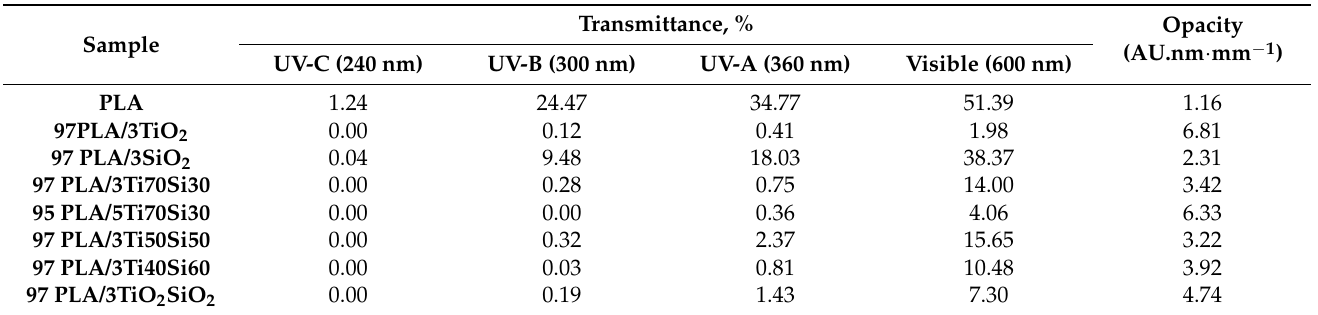
Table 4. Transmittance (%) and opacity values of PLA, PLA/TiO 2 , PLA/SiO 2 , PLA/Ti x Si y ,